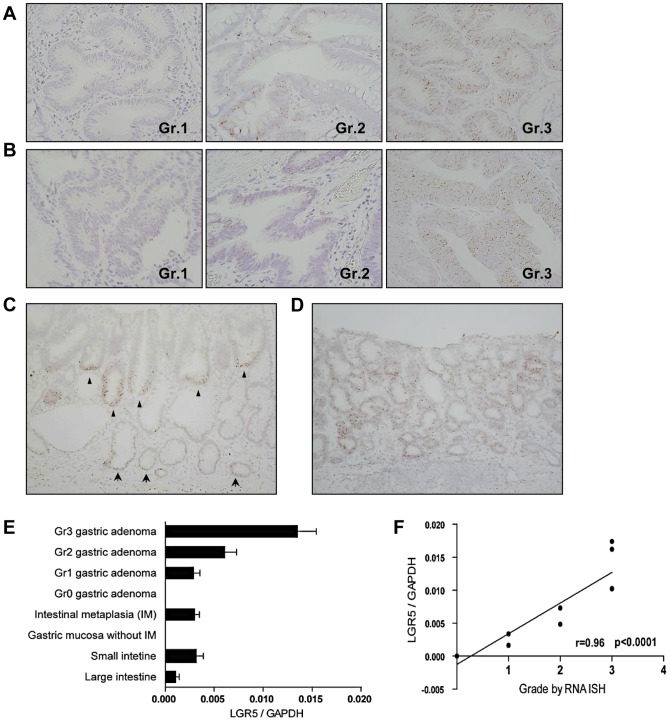

LGR5-expressing cells in gastric tumors.Tissue microarrays were constructed from gastric tumors, including gastric adenomas (GAs) (n = 75) and early gastric carcinomas (EAGs) (n = 68), that had been removed by endoscopic submucosal dissection. LGR5 expression in GAs (A) and EGCs (B) was classified according to the percentage of LGR5
+ tumor cells as grades 0, 1, 2, and 3. (C) Some GAs had a distinct LGR5
+ cell distribution that was restricted to the bases of tumor glands (marked by arrowheads); this distribution was quite similar to that of LGR5
+ cells in IM (indicated by arrows) observed around the tumor. (D) However, some GAs contained LGR5-expressing tumor cells in a relatively diffuse or patchy distribution pattern. (E) Semi-quantitative real-time PCR from formalin-fixed and paraffin-embedded GAs (n = 11), IM in the antrum (n = 3), GM without IM in the corpus (n = 4), and small (n = 4) and large (n = 4) intestinal tissues was performed to confirm the RNA in situ hybridization (ISH) results. (F) There was a positive correlation between the LGR5 grades in GAs as determined by RNA ISH and LGR5 transcript levels in RT-PCR (Spearman correlation coefficient  =  0.96; p<0.0001). Magnifications: A, B, ×400.